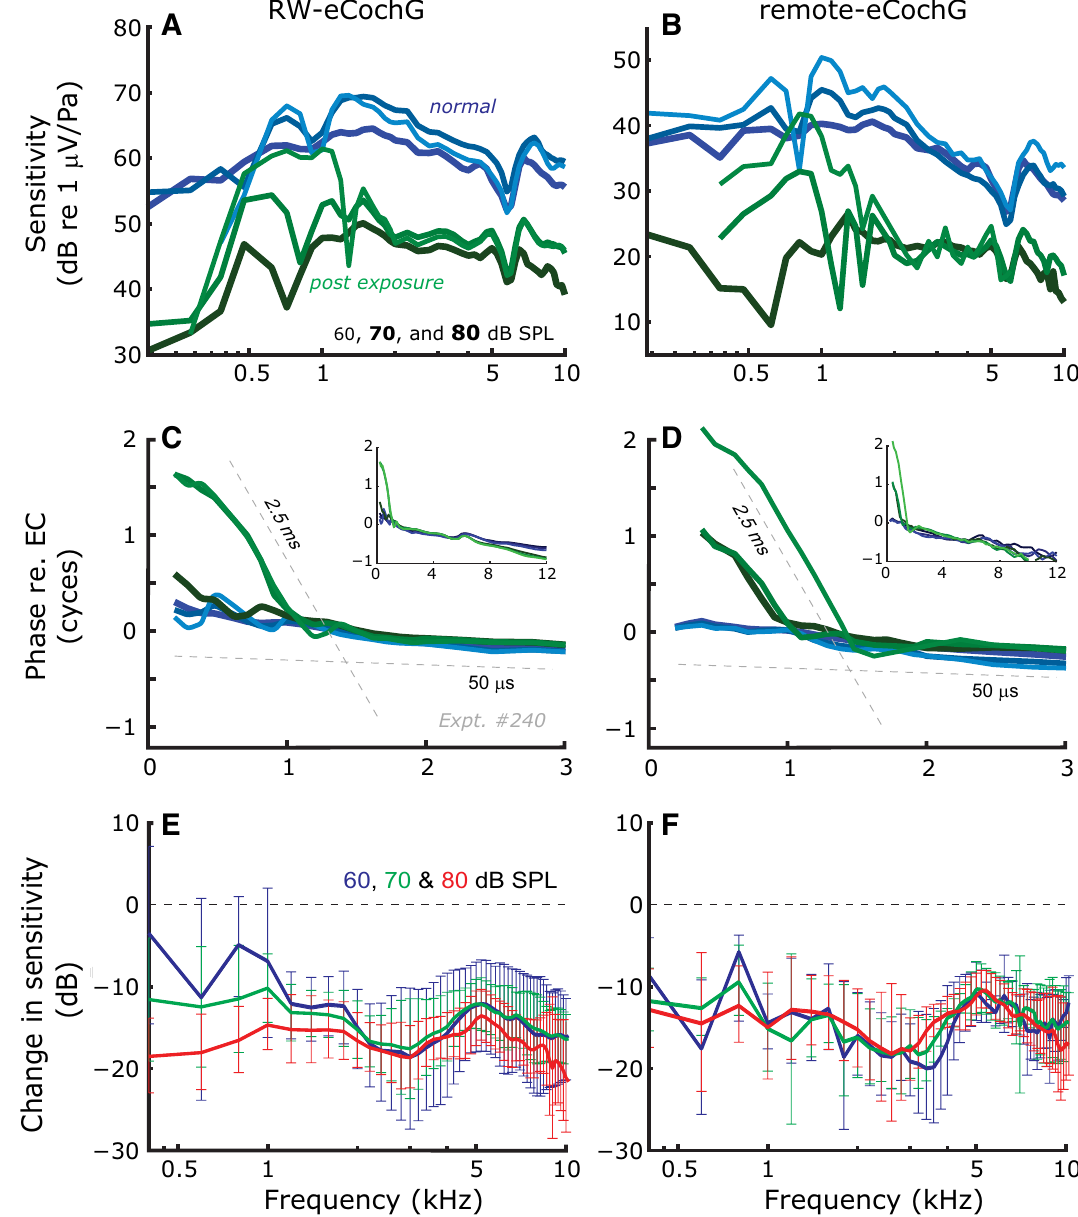
Figure 4. Effects of exposure to intense, broadband sound on RW- and remote-eCochG. Representative examples (Expt. #240) of eCochG sensitivity ( A , B ) and phase ( C , D ) before ( blue lines ) and after ( green lines ) exposure to intense (110 dB SPL, 15-20 min), broadband sound. Dashed lines in panels ( C , D ) indicate delays of 2.5 and 0.05 ms, respectively. The insets show phase data over an extended frequency range. ( E , F ) Average change in eCochG sensitivity (n = 5 animals) after exposure for stimulus levels of 60 ( blue lines ), 70 ( green lines ) and 80 dB SPL ( red lines ), respectively. Error bars denote ± 1